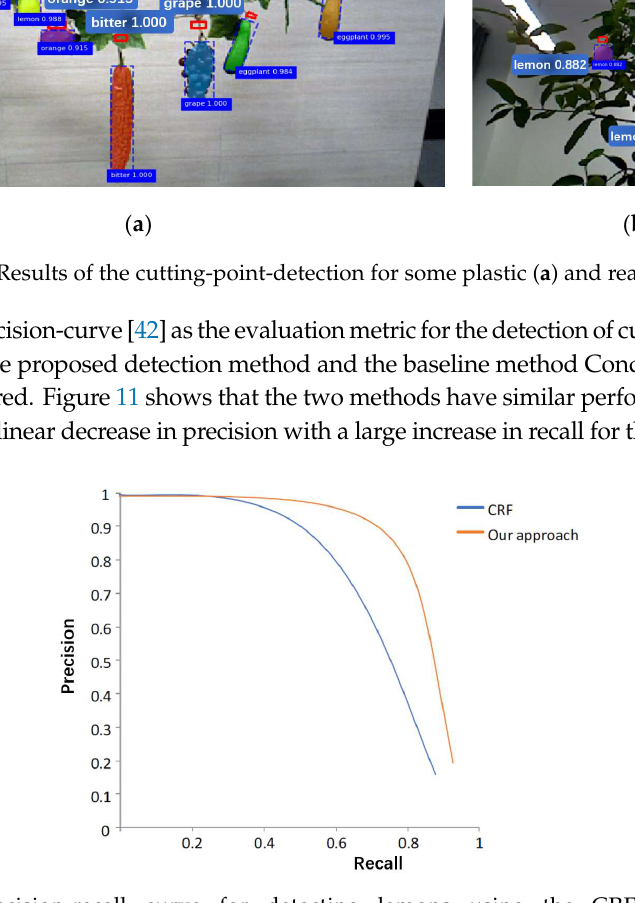
Harvesting Results